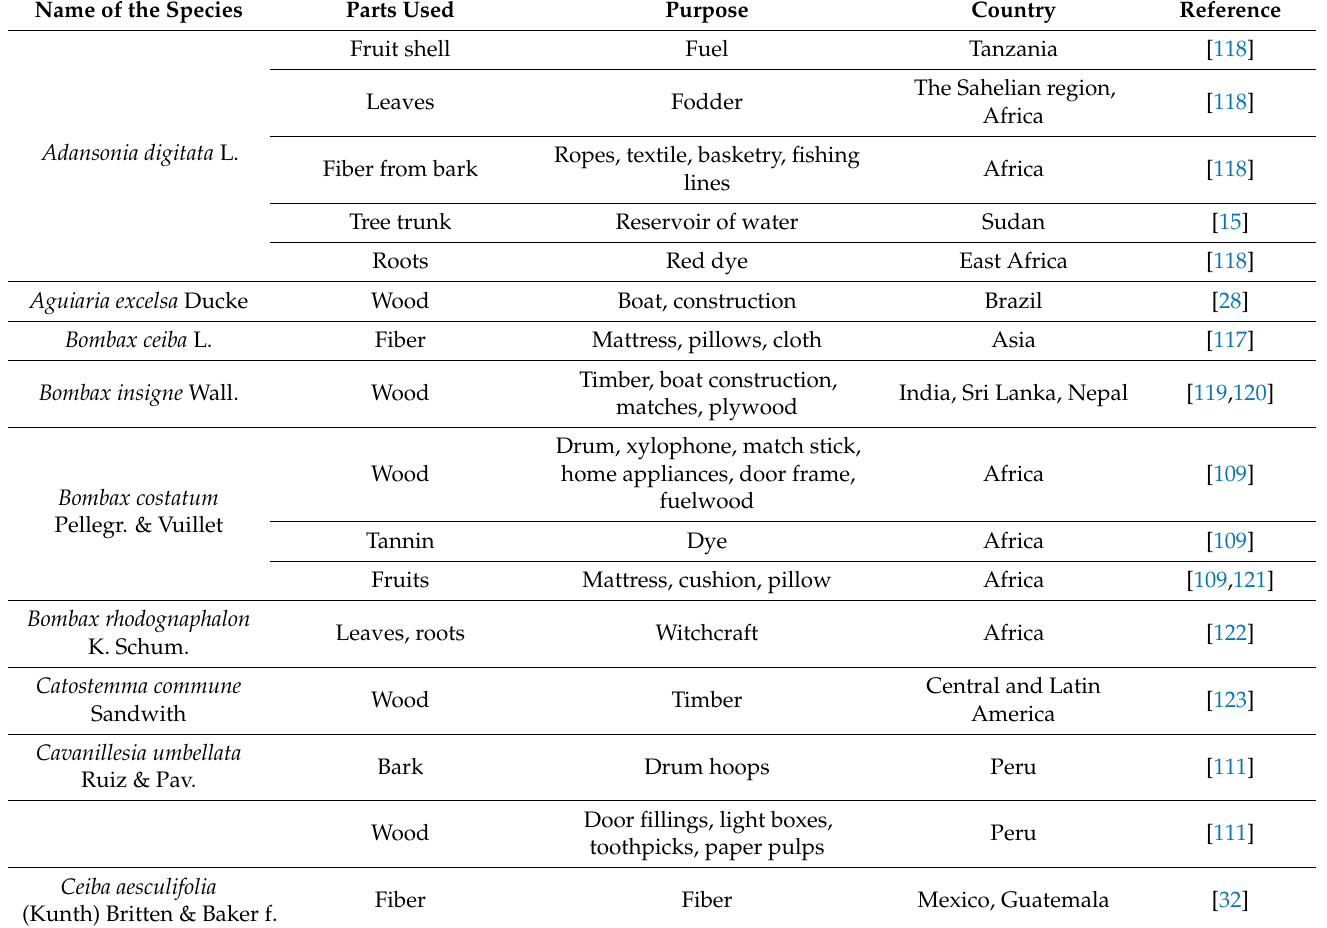
Table 4. Economic and traditional uses of Bombacoideae